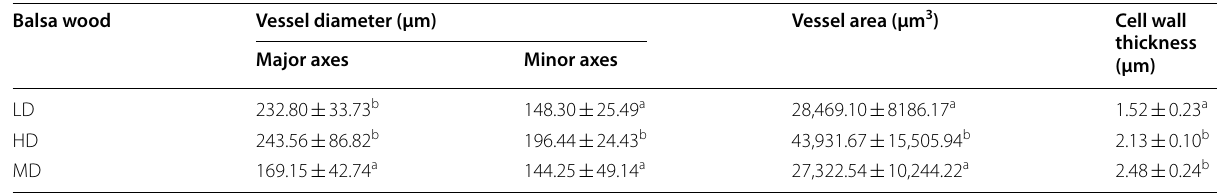
Table 1 Results of vessel diameter, vessel area, and cell wall thickness in three types of balsa wood Balsa wood